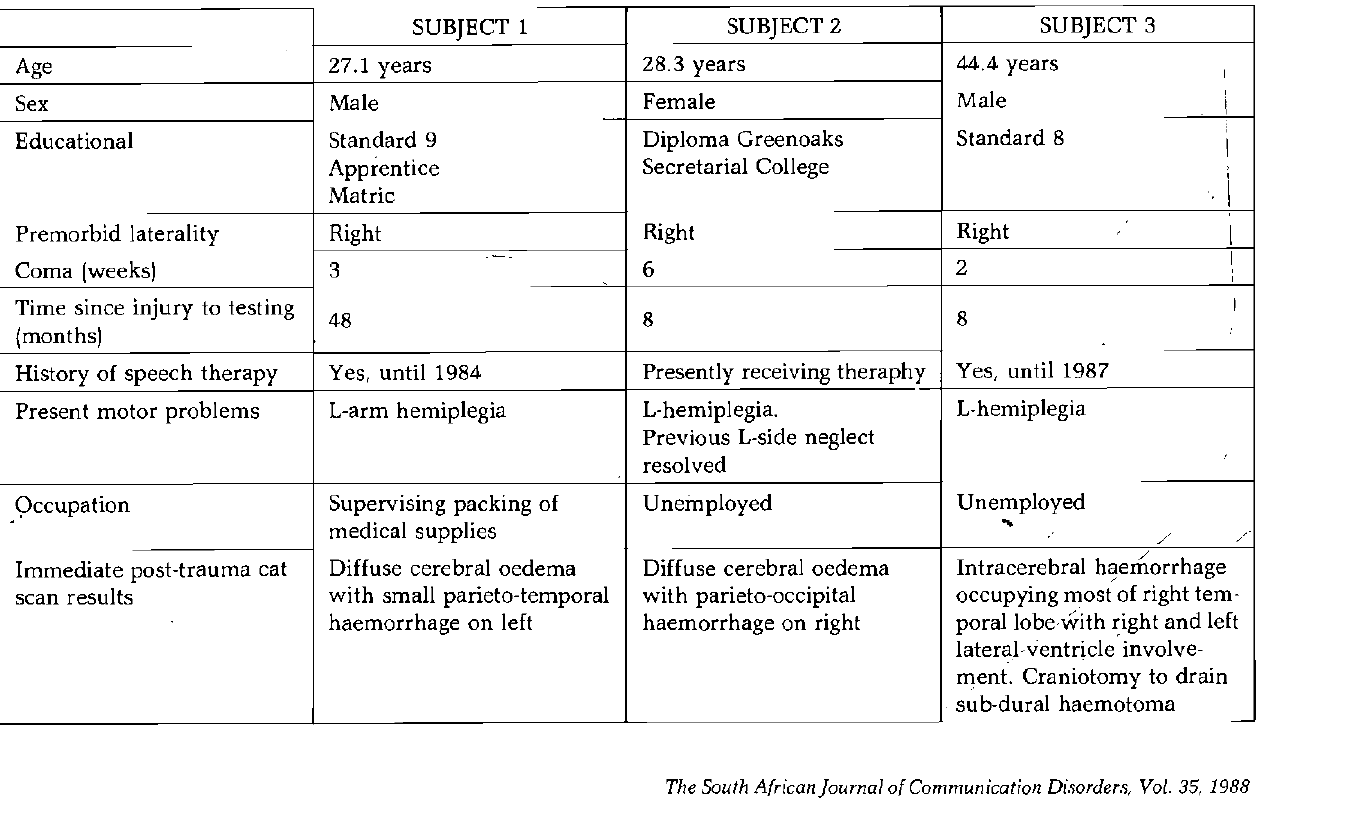
Table 1: Relevant clinical and biographical detail for all